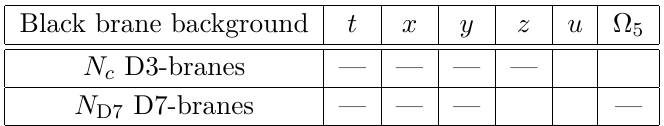
— — — — Table 1 . The configuration of the D-branes in the black brane background. “-” represents the D-brane extends along the